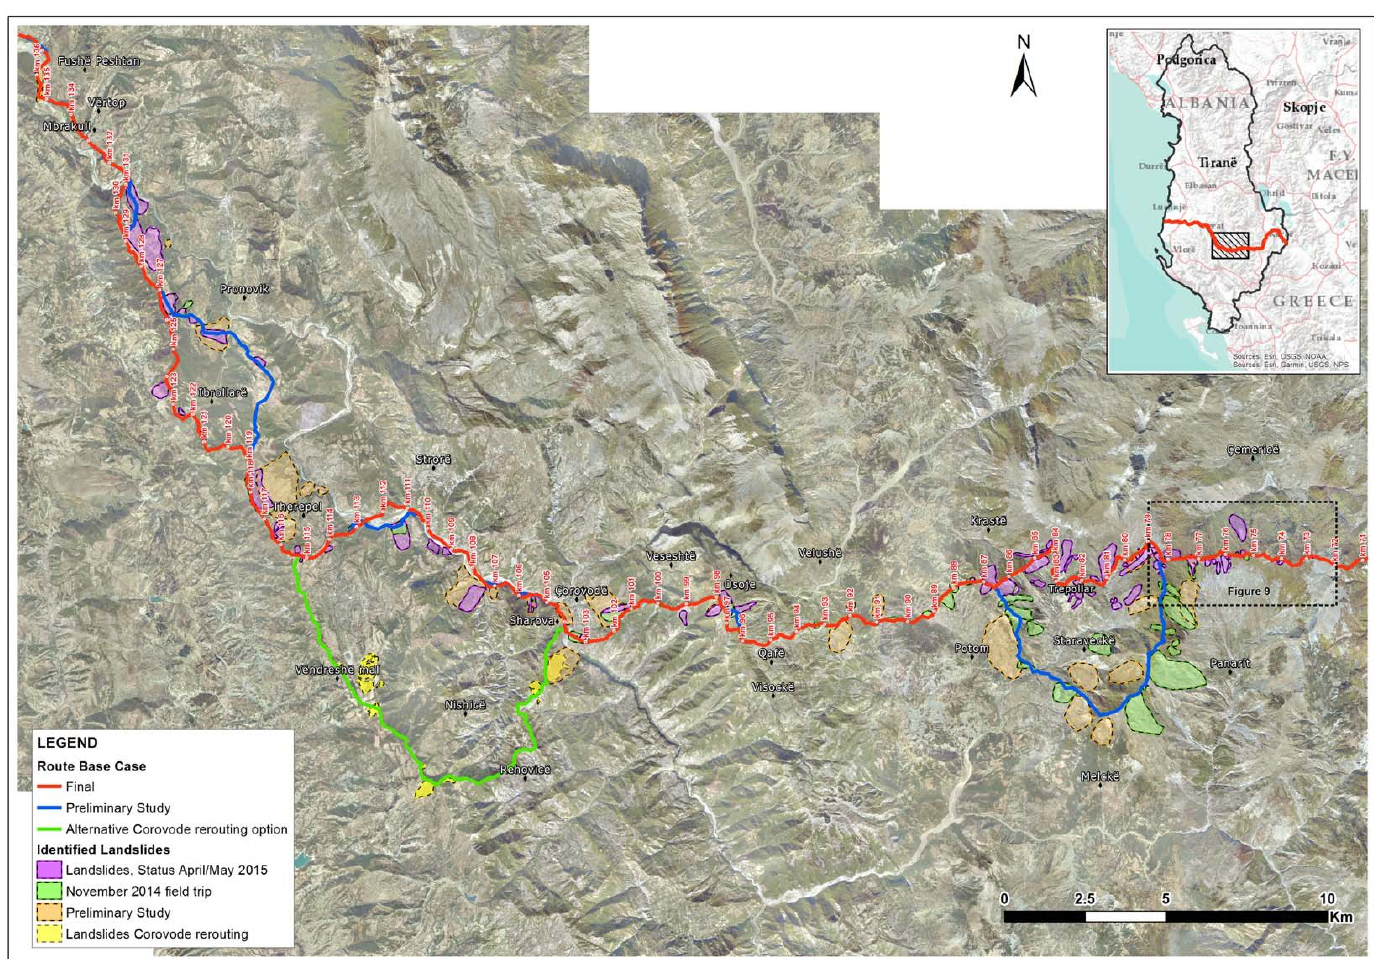
Figure 12. Inventory of 82 landslides compiled from satellite imagery and field survey. Landslides are depicted by polygons (colours indicate different study phases) for the whole area, verifying that landsliding was a major factor for the TAP pipeline route selection in this mountainous region. Different re-routings that were investigated in the field to avoid critical landslides are also presented.